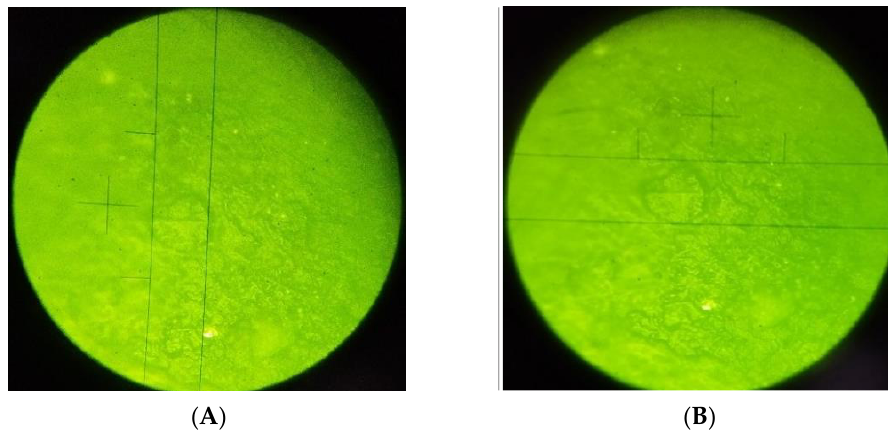
Figure 4. ( A ) Opus Bulk Fill without OIL control; ( B ) Opus Bulk Fill with OIL control.